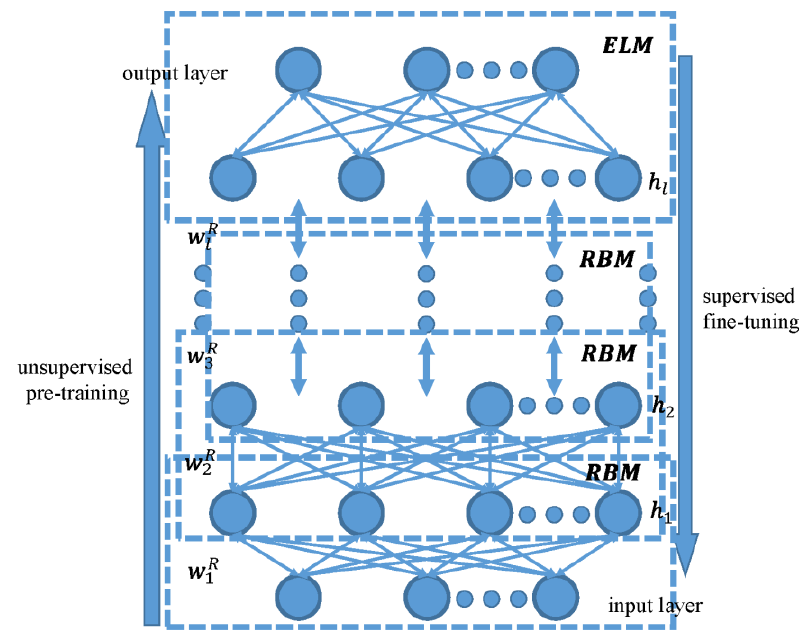
Figure 3. Improved deep belief network structure [100].